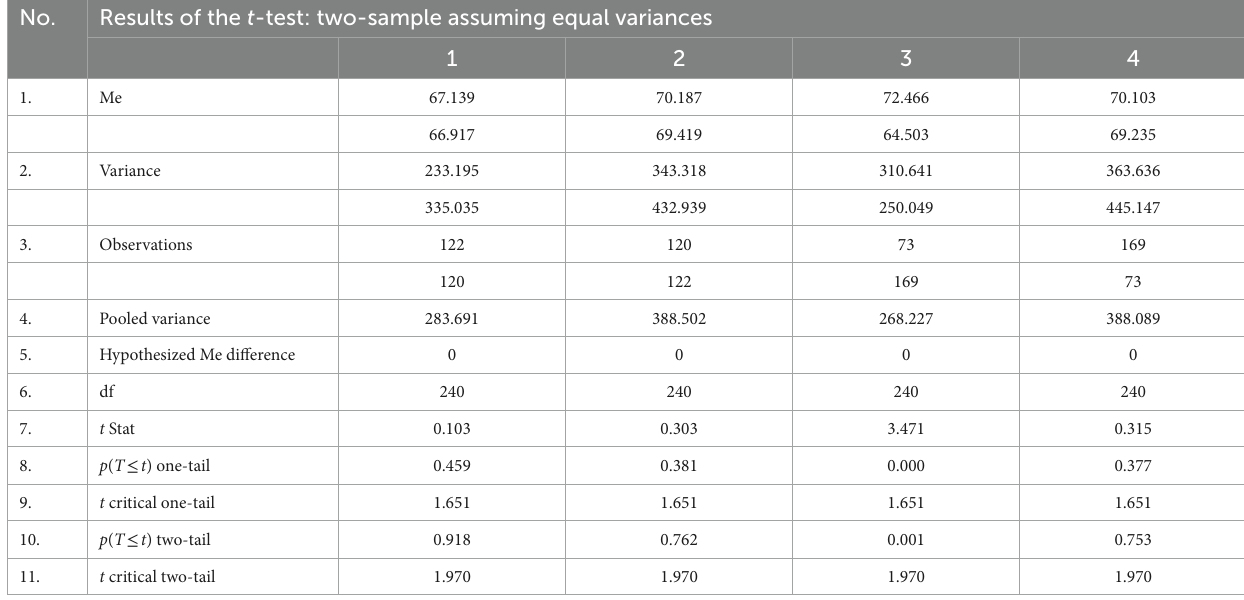
TABLE 3 The influence of gender and grade level on the students’ mathematics problem-solving understanding and their mathematics learning results.